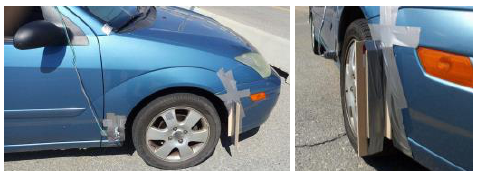
Figure 1. Ultrasonic sensor installation on the front right wheel of a Ford Focus Car.